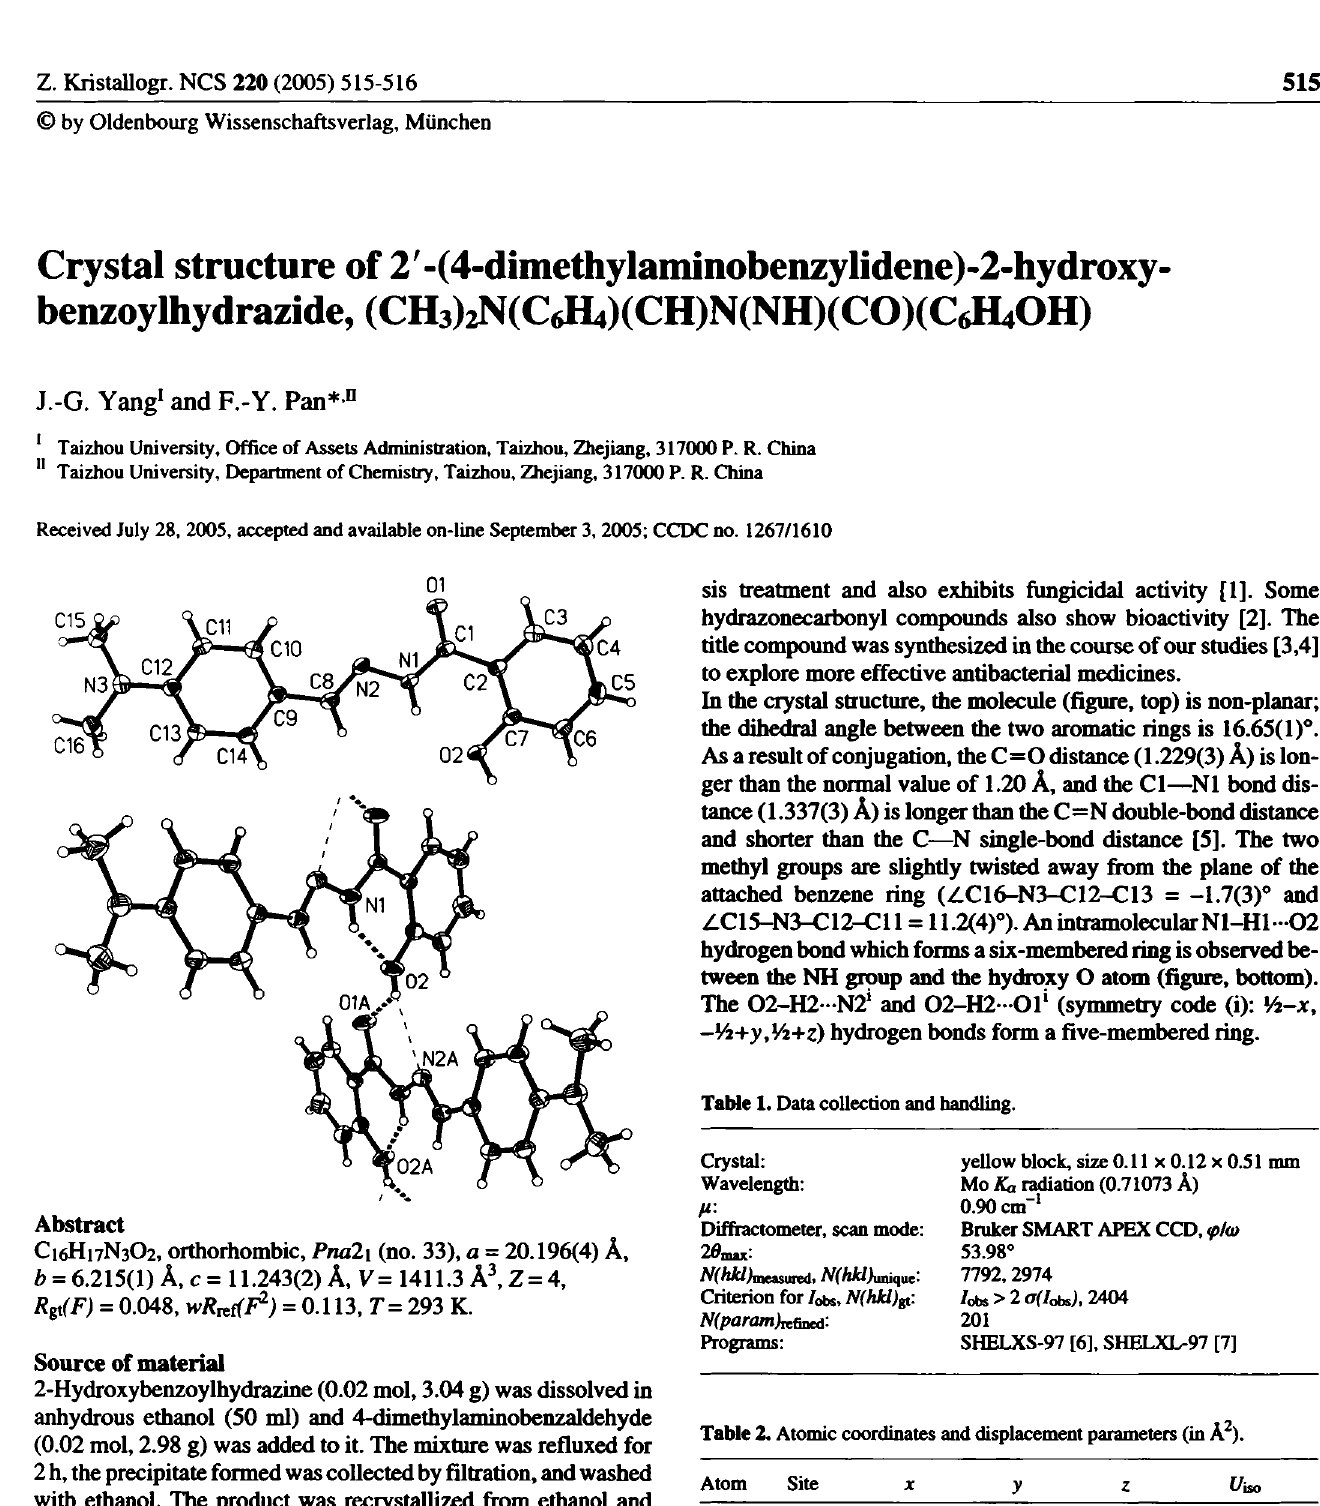
Table 2. Atomic coordinates and displacement parameters (in A 2